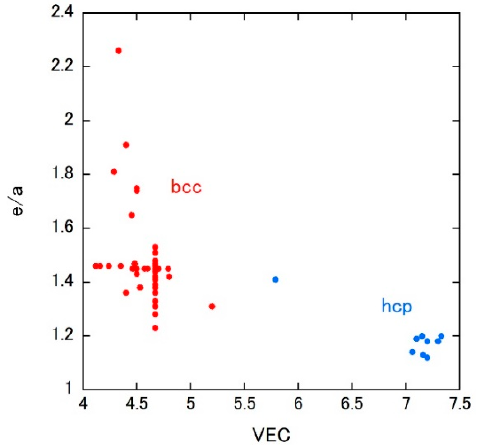
Figure 7. Phase selection diagram of bcc and hcp HEA superconductors. In hcp HEA superconductors, hcp-related superconductors are also included.